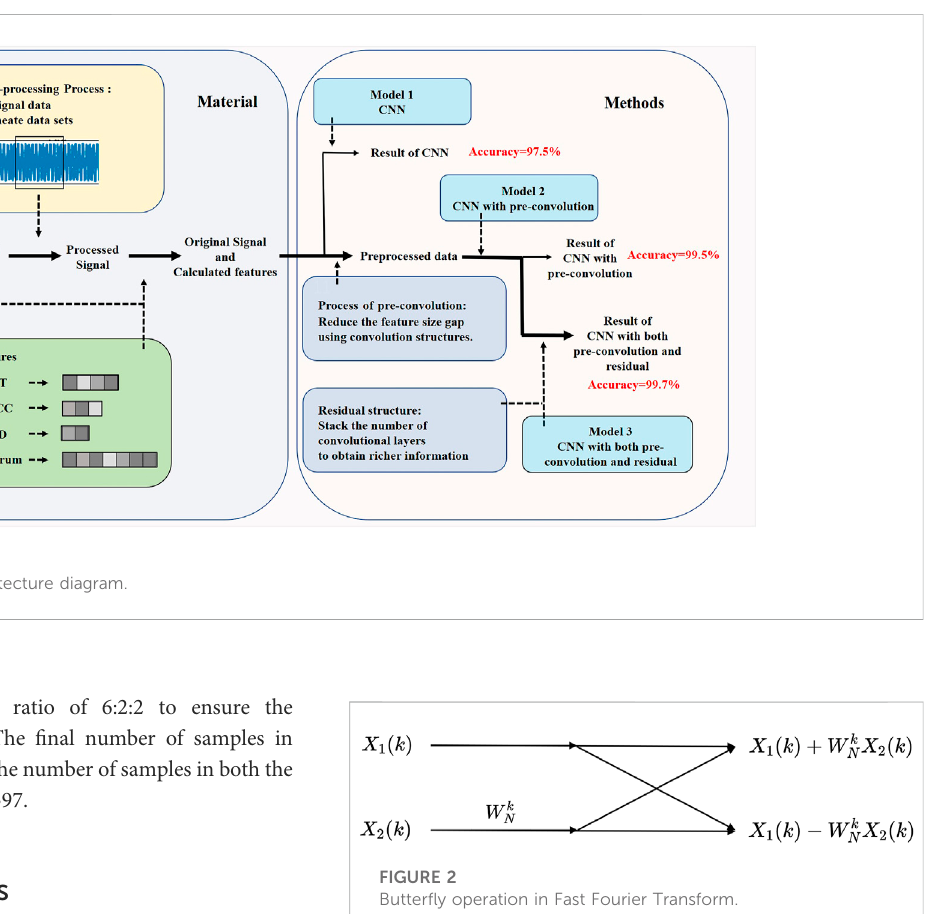
FIGURE 2 Butter fl y operation in Fast Fourier